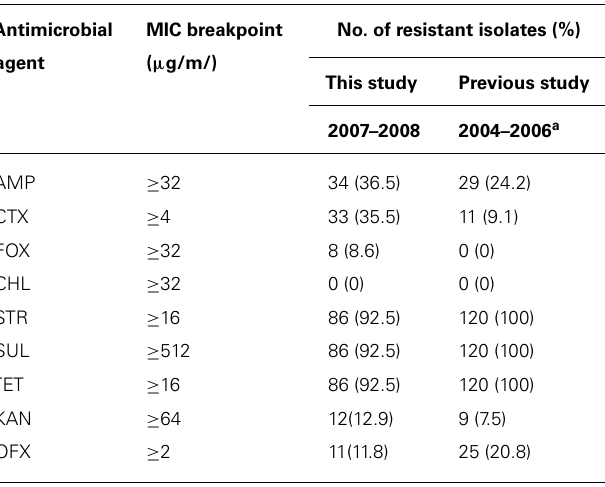
Table 1 |Antimicrobial susceptibility among 93 Salmonella Infantis isolates detected in this study Antimicrobial